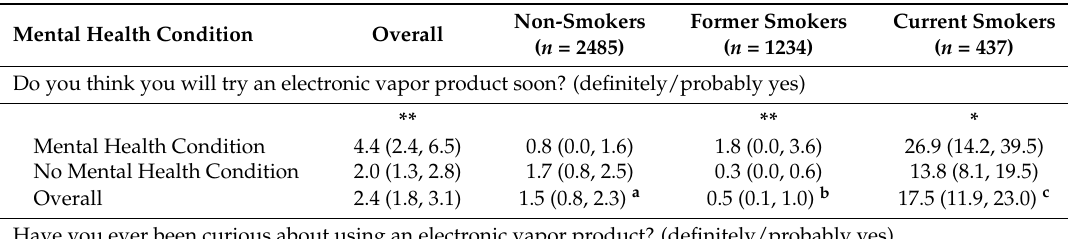
Table 6. Susceptibility to ENDS use (among participants who have never used